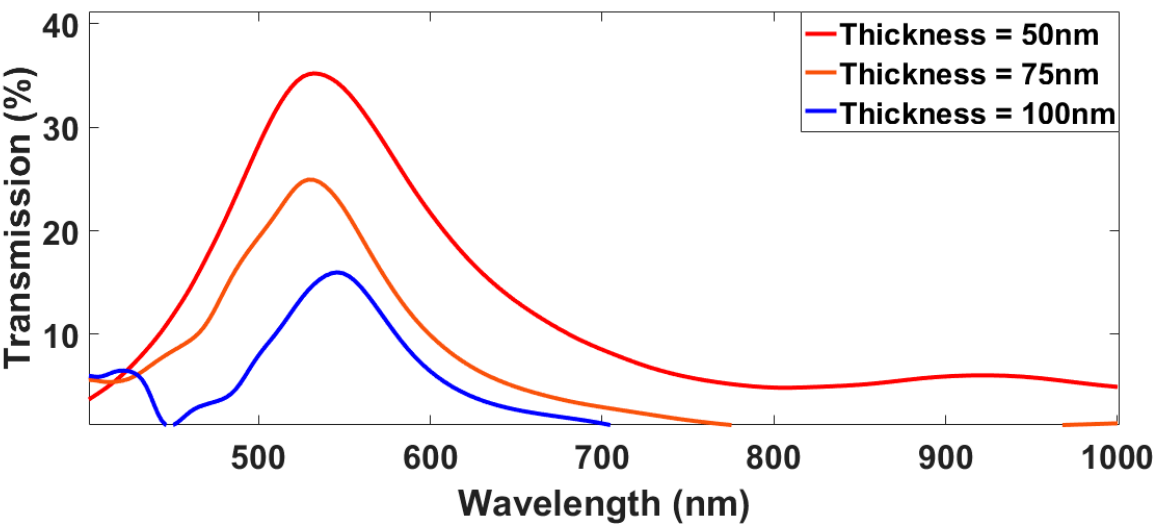
Figure 4. The transmission spectrums of the proposed structure with different thicknesses of Al were calculated.